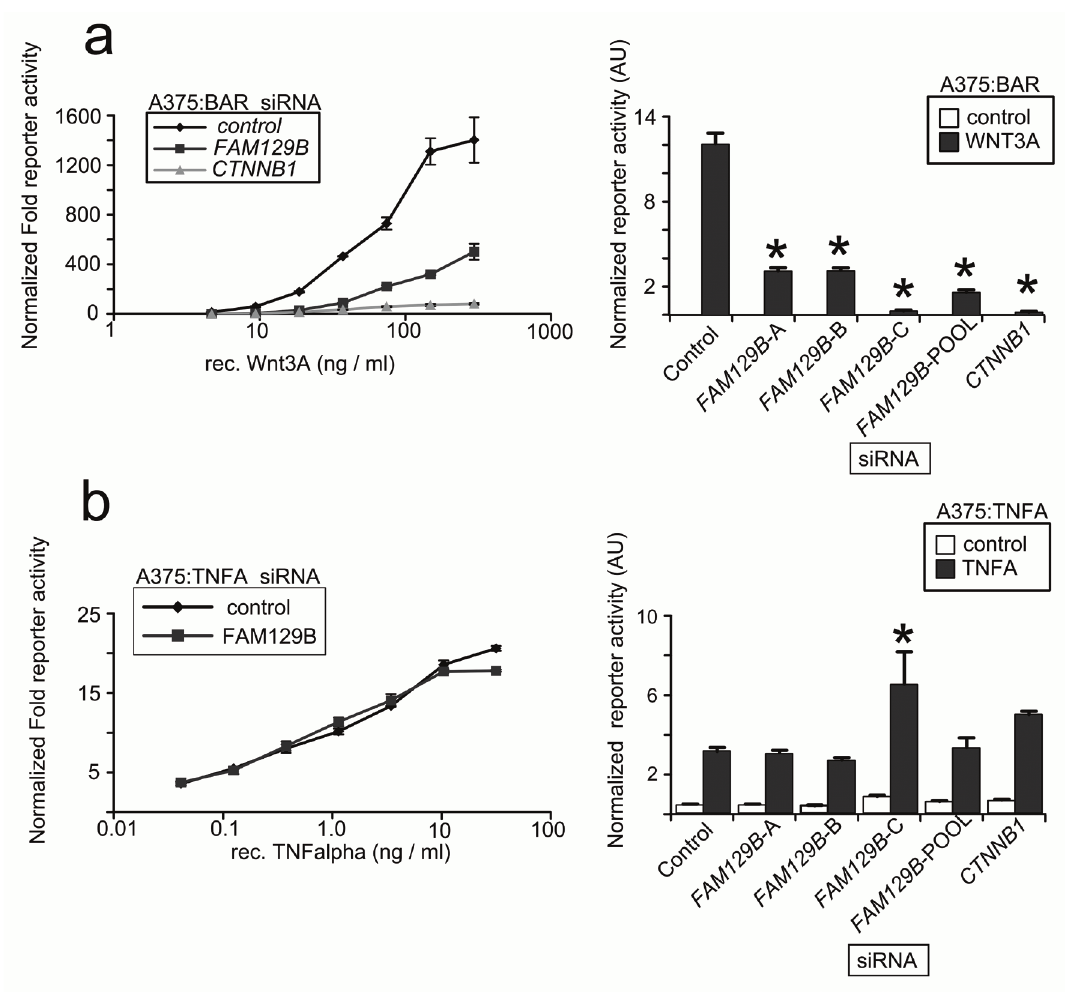
Figure 3. FAM129B siRNA regulate Wnt-dependent transcriptional reporter, but not TNF α /NF κ B dependent reporter. ( a, left panel) pooled FAM129B siRNAs inhibit Wnt-dependent BAR reporter activity over a wide range of doses. Increasing doses of WNT3A increases activation of the BAR reporter (normalized to constitutive Renilla luciferase in control treated cells). WNT3A does not activate the reporter in the presence of FAM129B or CTNNB1 siRNAs. (Right panel) A375 cells were treated with siRNAs as indicated and treated with an EC50 dose of WNT3A (50 ng/ml). All FAM129B siRNA and positive control CTNNB1 siRNA inhibit Wnt-dependent BAR reporter activity. ( b ) The same experiment was carried out as in ( a , left panel) in A375 lines TNF α /NF κ B reporter. Data in the left panel indicate dose-dependent activation of the NF κ B reporter by TNF α . However, FAM129B siRNAs do not inhibit the activation of the TNF α /NF κ B reporter. (Right panel) FAM129B siRNA do not regulate activity of the NF κ B reporter activated by 1.5 ng TNF α /ml in A375 cells. High dose TNF α (10 ng/ml) does differentially activate the reporter. Data represent 3 separate biological replicates. *p<0.05 by unpaired, two-tailed